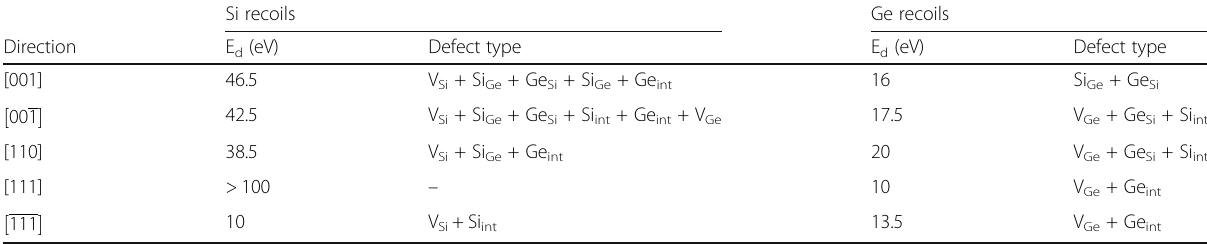
Table 2 The calculated threshold displacement energies and associated defects after the recoil events in Si/Ge superlattice. V X : X vacancy ( X = Si or Ge); X int : X interstitial ( X = Si or Ge); X Y : X occupying the Y lattice site ( X and Y = Si or Ge) Si recoils Ge recoils Direction E d (eV) Defect type E d (eV) Defect